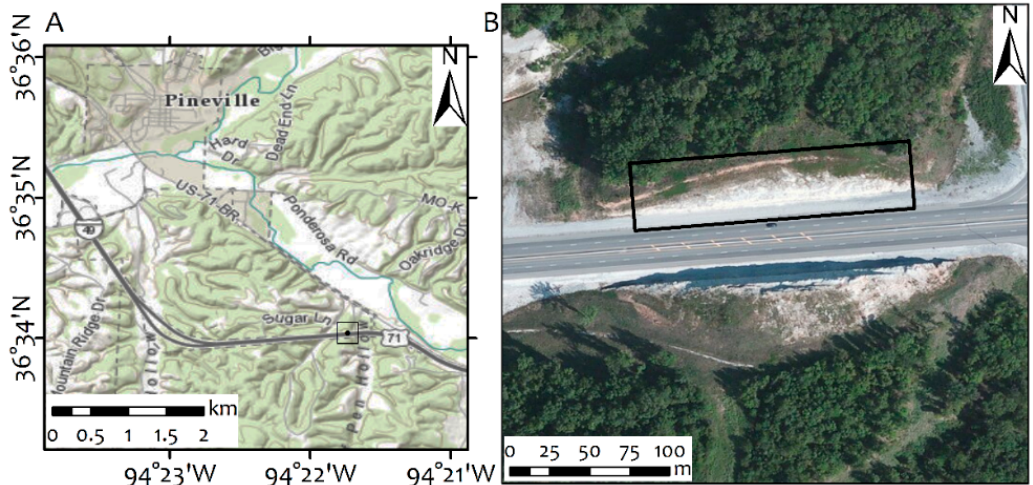
Figure 4. ( A ) Location of the roadcut on US-71 Hwy near Pineville hosting Reeds Spring Formation; ( B ) high-resolution satellite imagery of the studied roadcut. The solid black line depicts the scanned outcrop face of the roadcut. Both topographic map and high-resolution satellite imagery are courtesy of ESRI ArcGIS online.